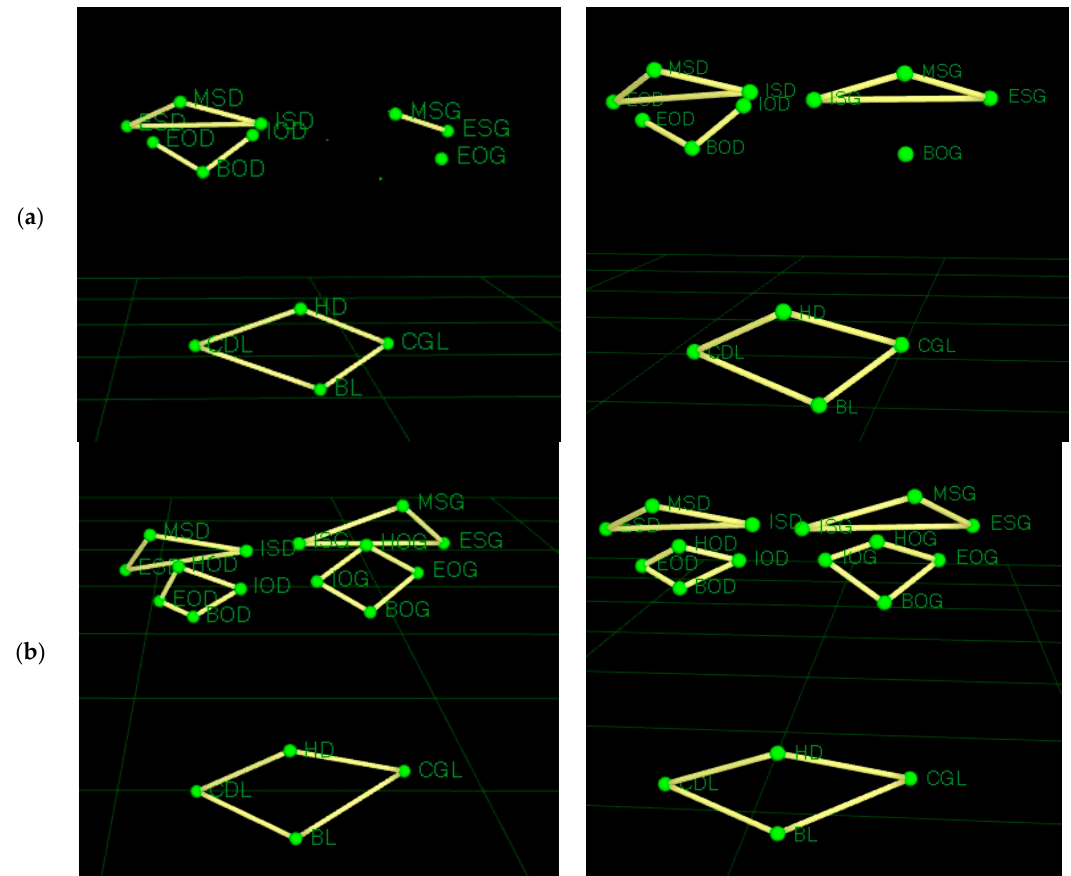
Figure 3. Overview of the two acquired data ( a ) Overlapping image, ( b ) the most significant image